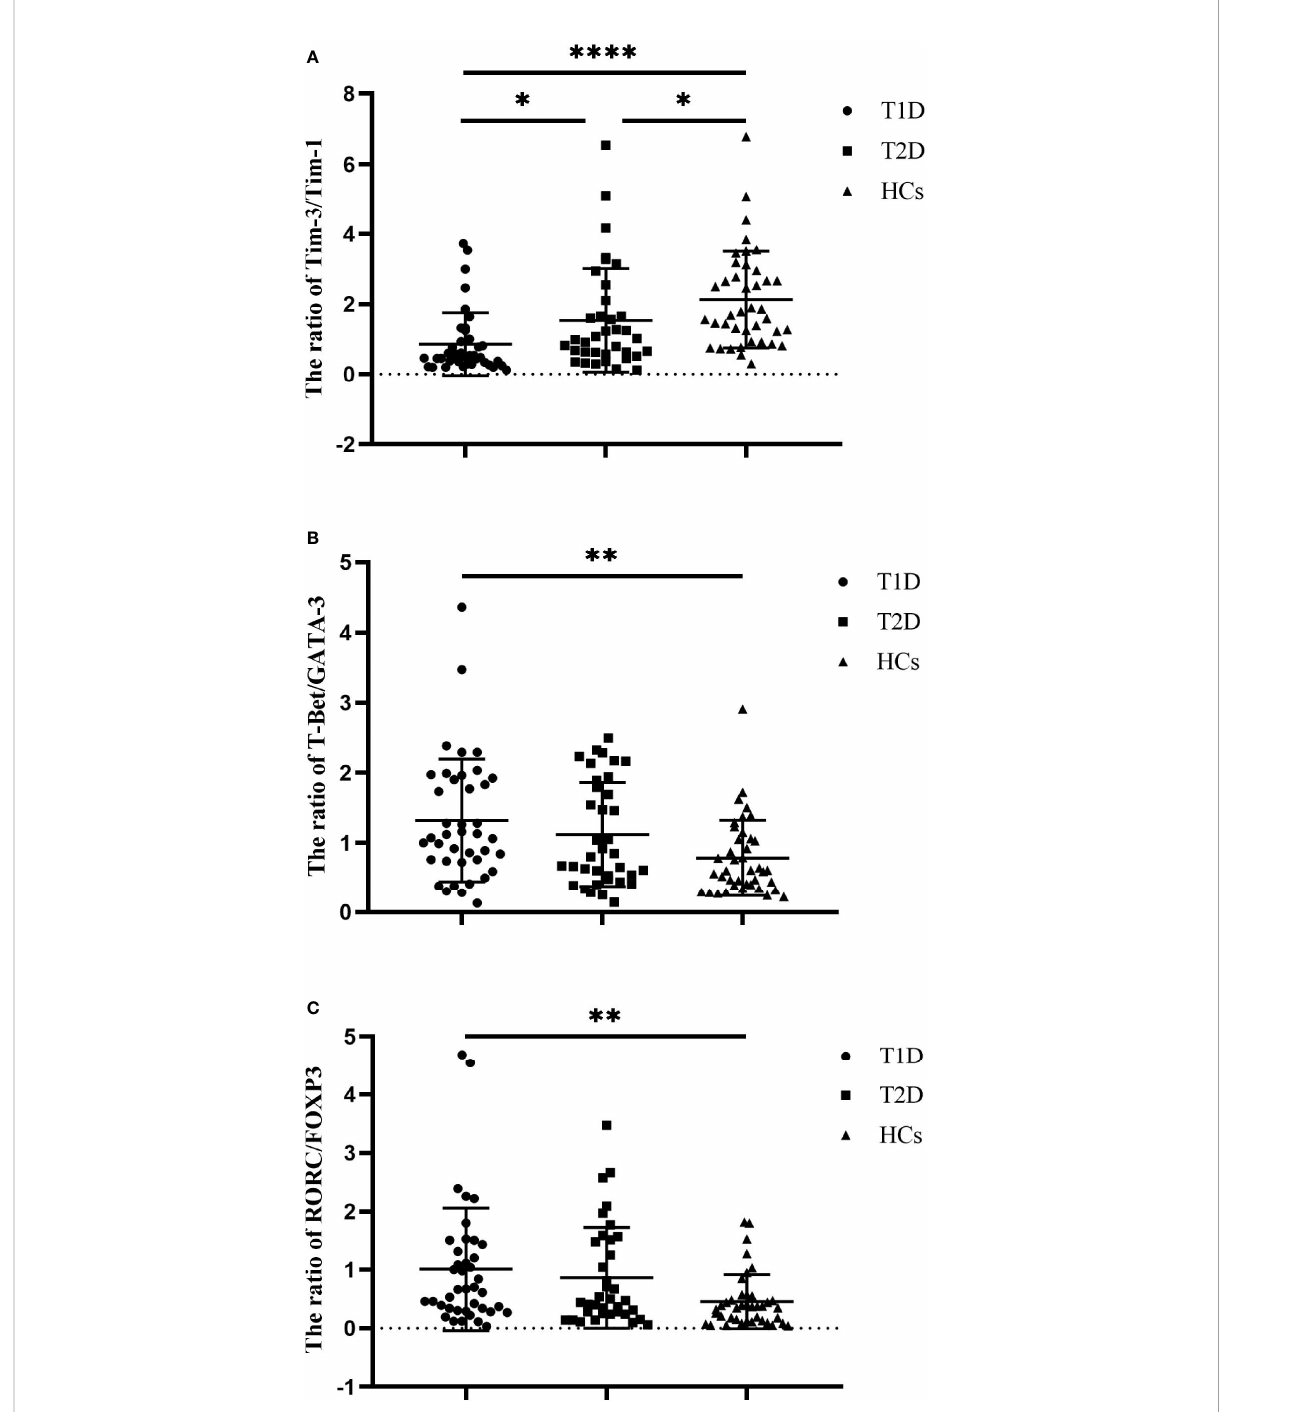
FIGURE 2 The ratios of Tim molecules and T-cell subset-speci fi c transcription factor expression in T1D patients (n=40), T2D patients (n=36) and HCs (n=40). (A) The ratio of Tim-3 to Tim-1 expression in T1D patients, T2D patients and HCs. (B) The ratio of T-Bet to GATA3 expression in T1D patients, T2D patients and HCs. (C) The ratio of RORC to POXP3 expression in T1D patients, T2D patients and HCs. The error bars represent the standard deviation of the mean. * P <0.05; ** P <0.01; **** P